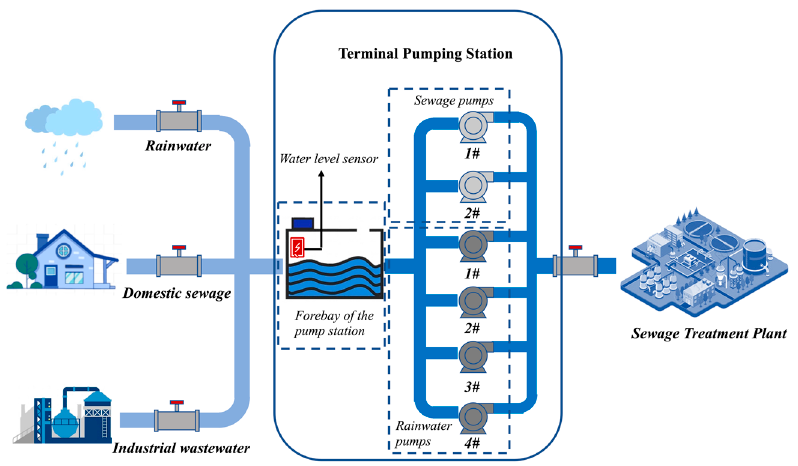
Figure 4. The schematic of the drainage system in Huangpu District.